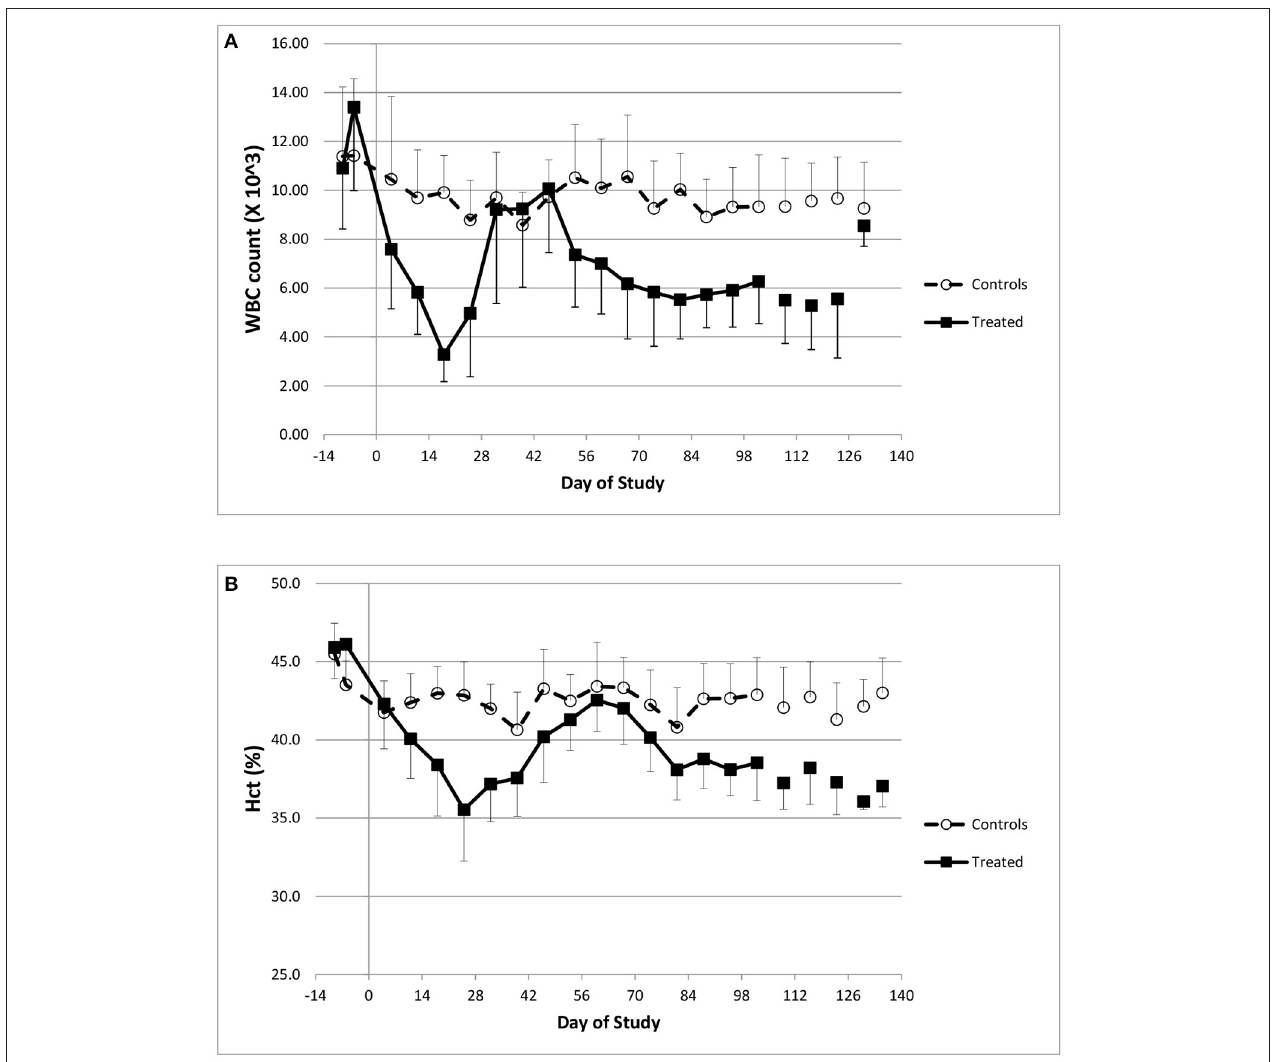
FIGURE 1 | Hematology changes. Changes in white blood cell counts (A) and Hematocrit (B) over the course of the